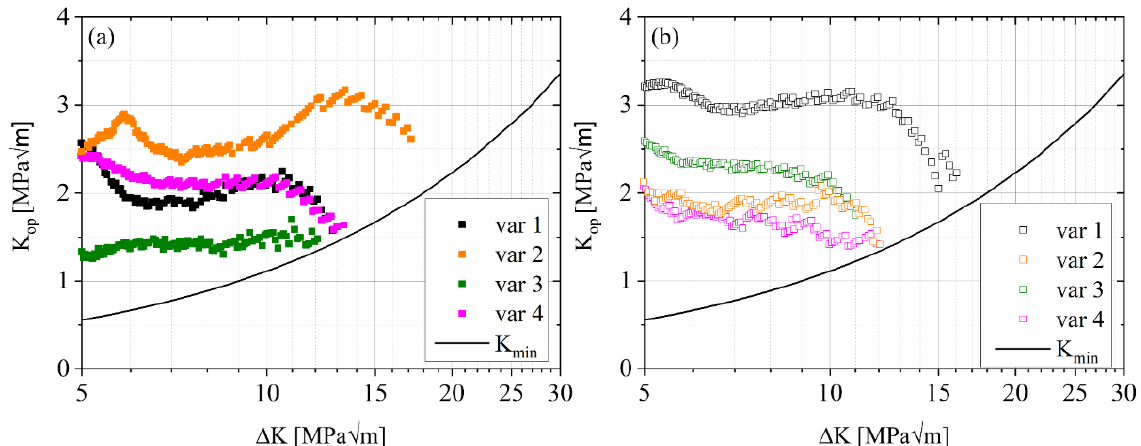
Figure 7. Opening stress intensity factor K op determined by the measured crack opening force F op. ( a ) in L-T orientation and ( b ) in T-L orientation.